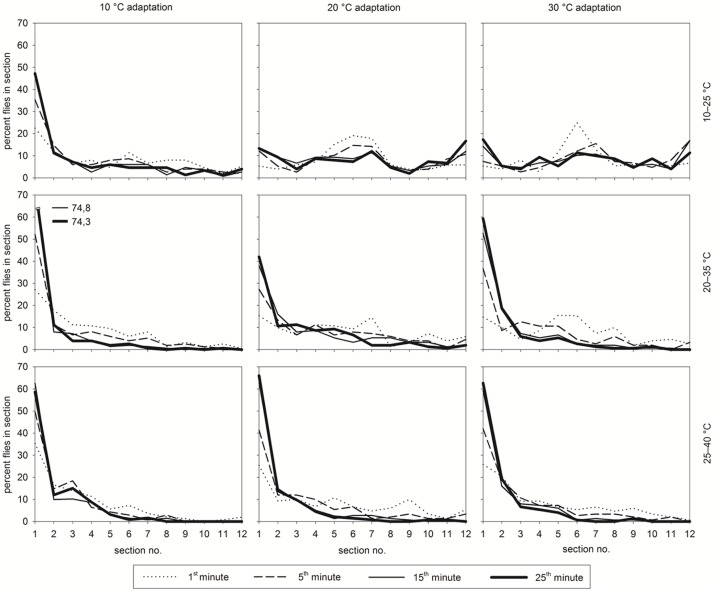
Distribution of D. suzukii (%) after adaptation to 10, 20, or 30°C across temperature sectors of three temperature gradients (10–25, 20–35, and 25–40°C).